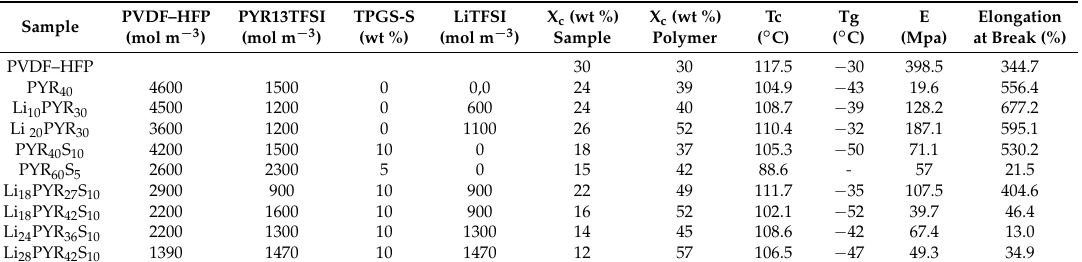
Table 1. Formulation; crystallinity (in wt %) referred to the sample, X c sample, and to the PVDF–HFP, X c polymer; thermal properties (crystallization temperature, Tc; glass transition temperature, Tg) and mechanical properties (Young´s modulus, E, and elongation at